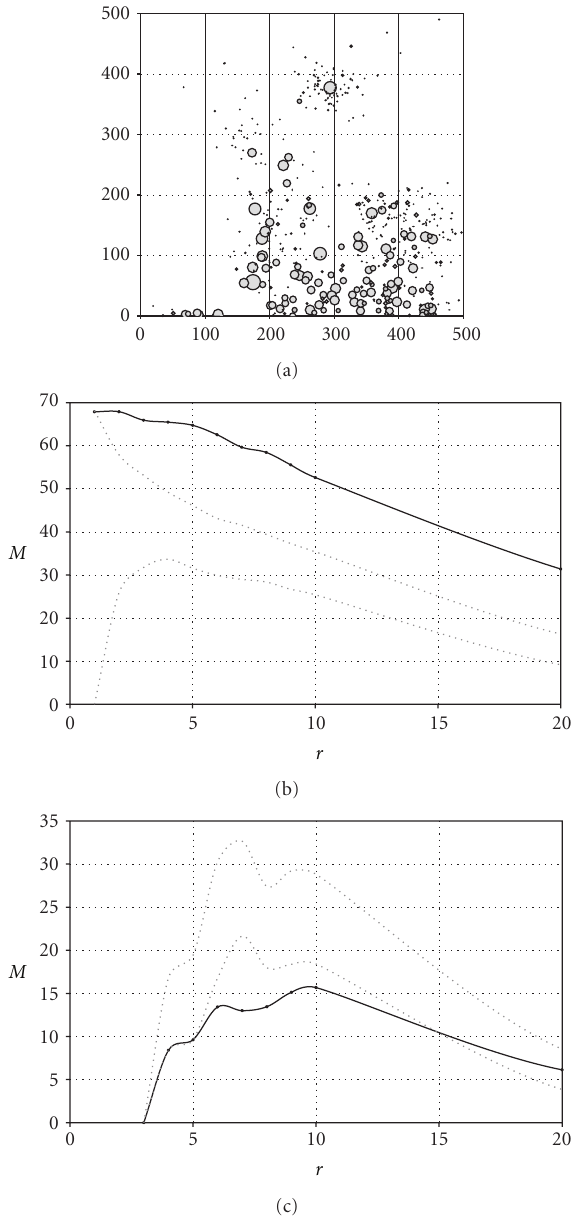
Figure 10: Regeneration of Vouacapoua americana . (a) The map shows trees with their size. Distances are in meters. (b) Univariate M function applied to saplings: saplings are aggregated at all distances. (c) Bivariate M function applied to saplings around potentially reproducing trees (over 30cm DBH): a significant lack of saplings is detected between 6 and 9 meters. Confidence intervals are computed at 1% risk